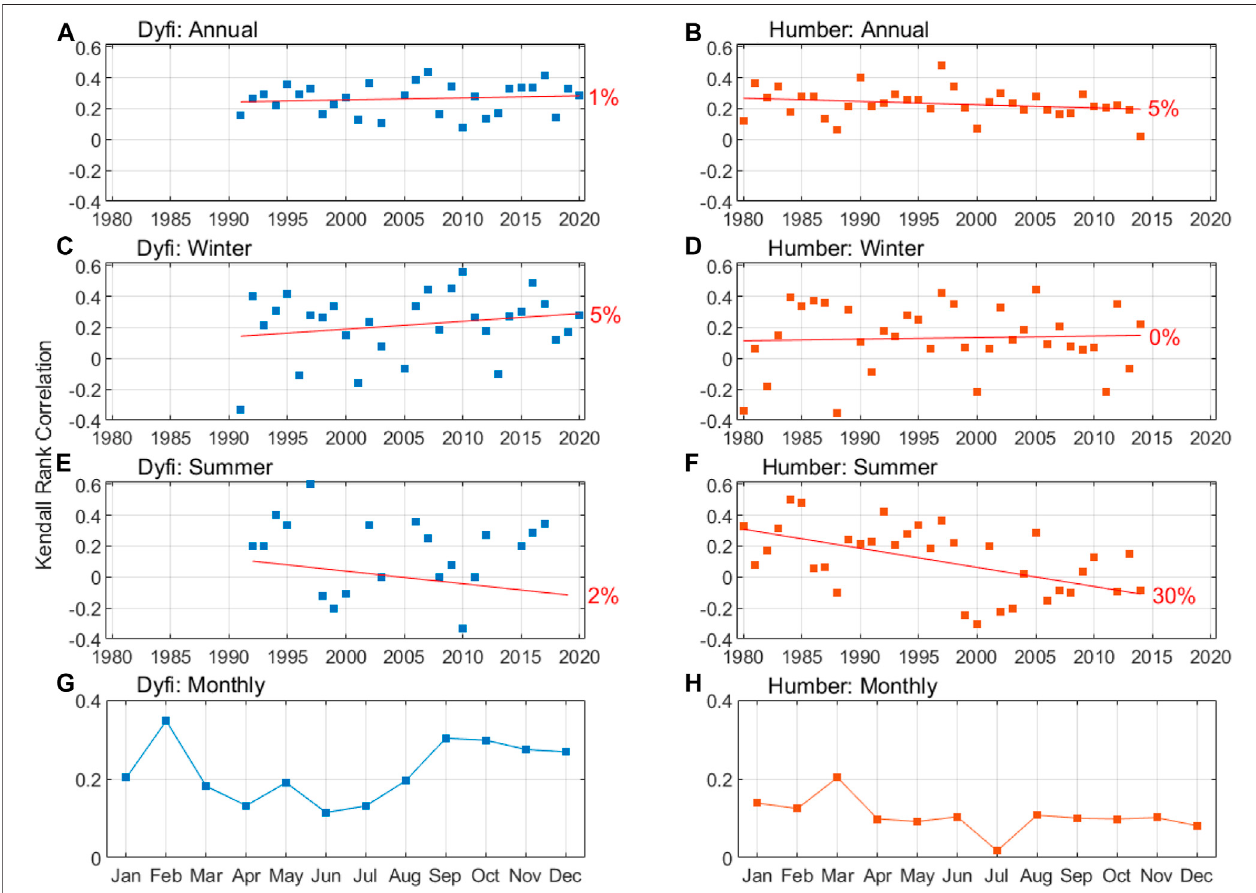
FIGURE 6 | Kendall Rank correlation coef fi cients comparing daily peak fl uvial fl ow with daily maximum skew surge, grouped (A – B) inter-annually, (C – D) inter- winters (Dec – Feb), (E – F) inter-summers (May – Jul), and (G – H) monthly. The left panels represent the Dy fi and right panels the Humber.